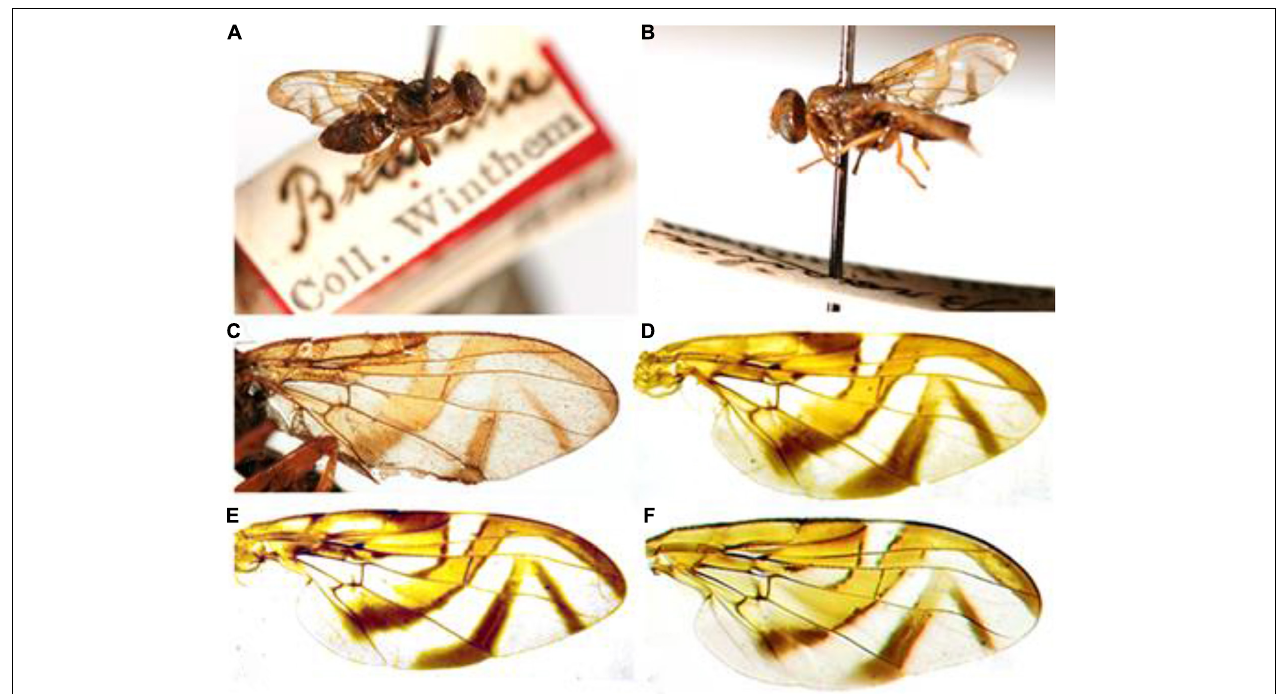
FIGURE 6 | The Anastrepha fraterculus type specimen. (A,B) Micrographs of the male type specimen of Anastrepha fraterculus housed in the Naturhistorisches Museum Wien (NMW) (photos by Carlos Ribeiro Vilela); (C) right wing of the type specimen used for morphometric examination; (D) wing of A . sp.1; (E) wing of A . sp.2; (F) wing of A . sp.3.